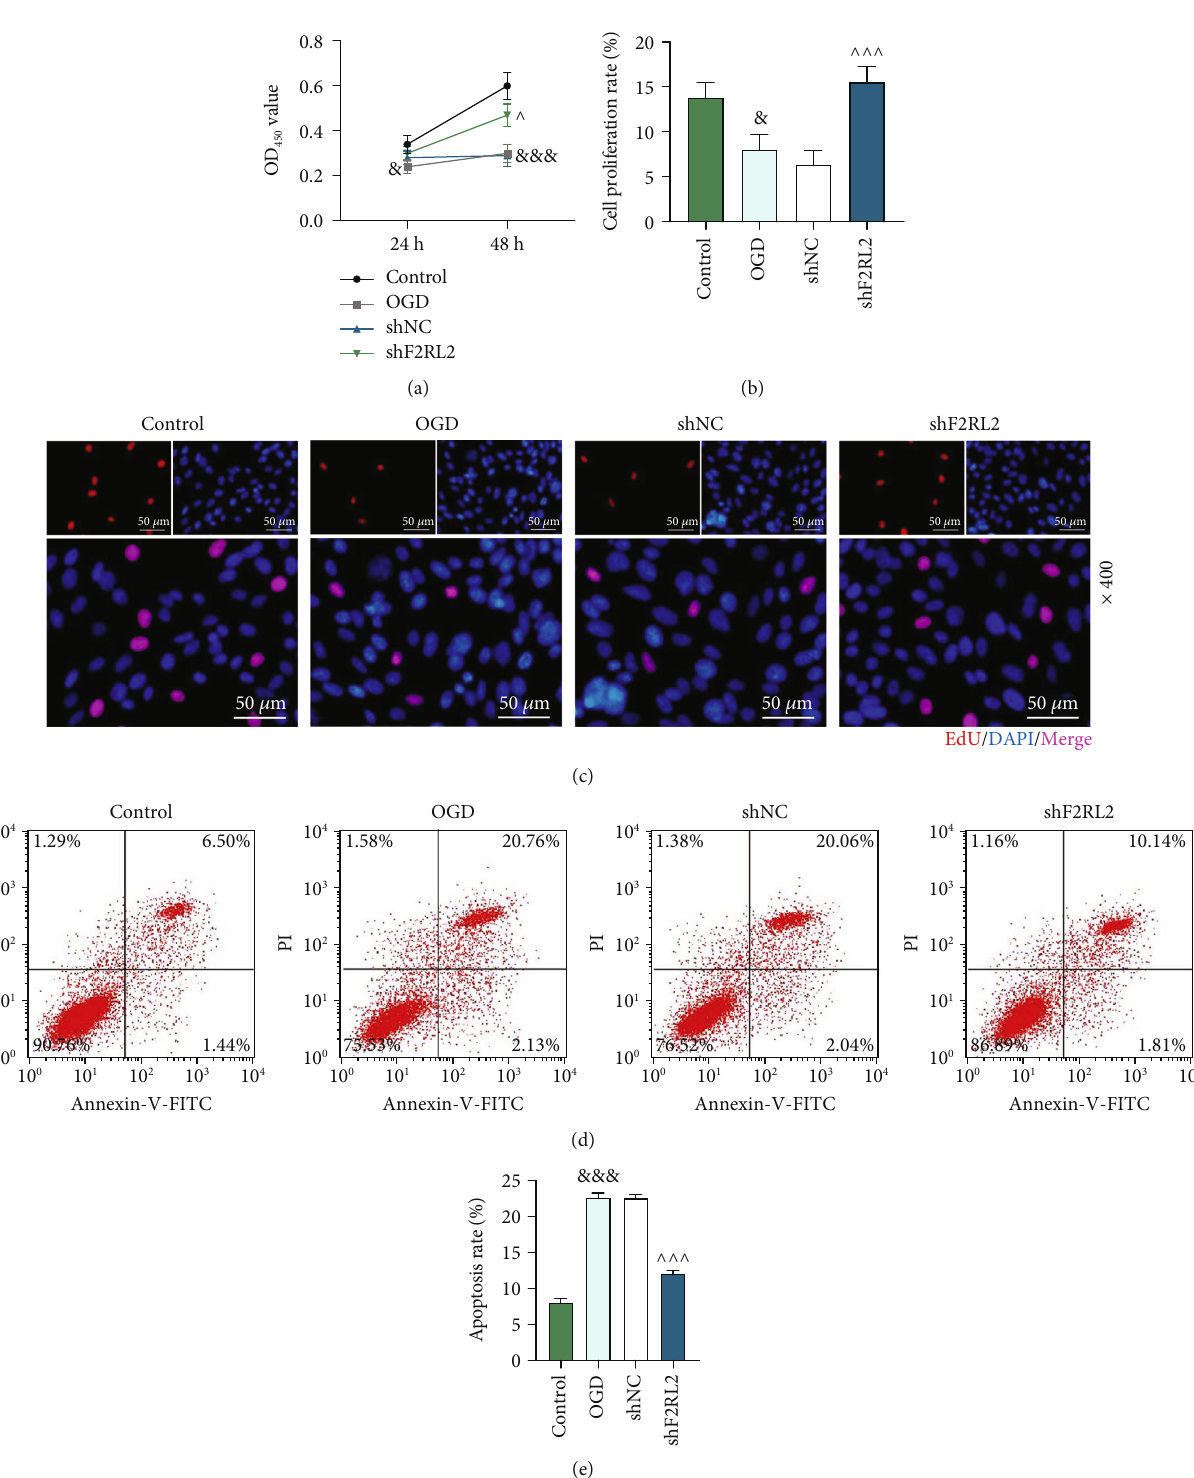
Figure 5: F2RL2 downregulation ameliorated the decreased viability and proliferation and the increased apoptosis of OGD-induced HCMs. (a) After cells received transfection and OGD induction, the viability of HCMs was detected by CCK-8 assay. (b, c) After cells received transfection and OGD induction, the proliferation of HCMs was evaluated using EdU staining (magni fi cation × 400). (d, e) After cells received transfection and OGD induction, the apoptosis of HCMs was examined using fl ow cytometry. ( & P < 0 : 05 and &&& P < 0 : 001 , vs. control; ^ P < 0 : 05 and ^^^ P < 0 : 001 , vs. shNC) (HCMs: human cardiac myocytes; F2RL2: coagulation factor II thrombin receptor like 2; OGD: oxygen-glucose